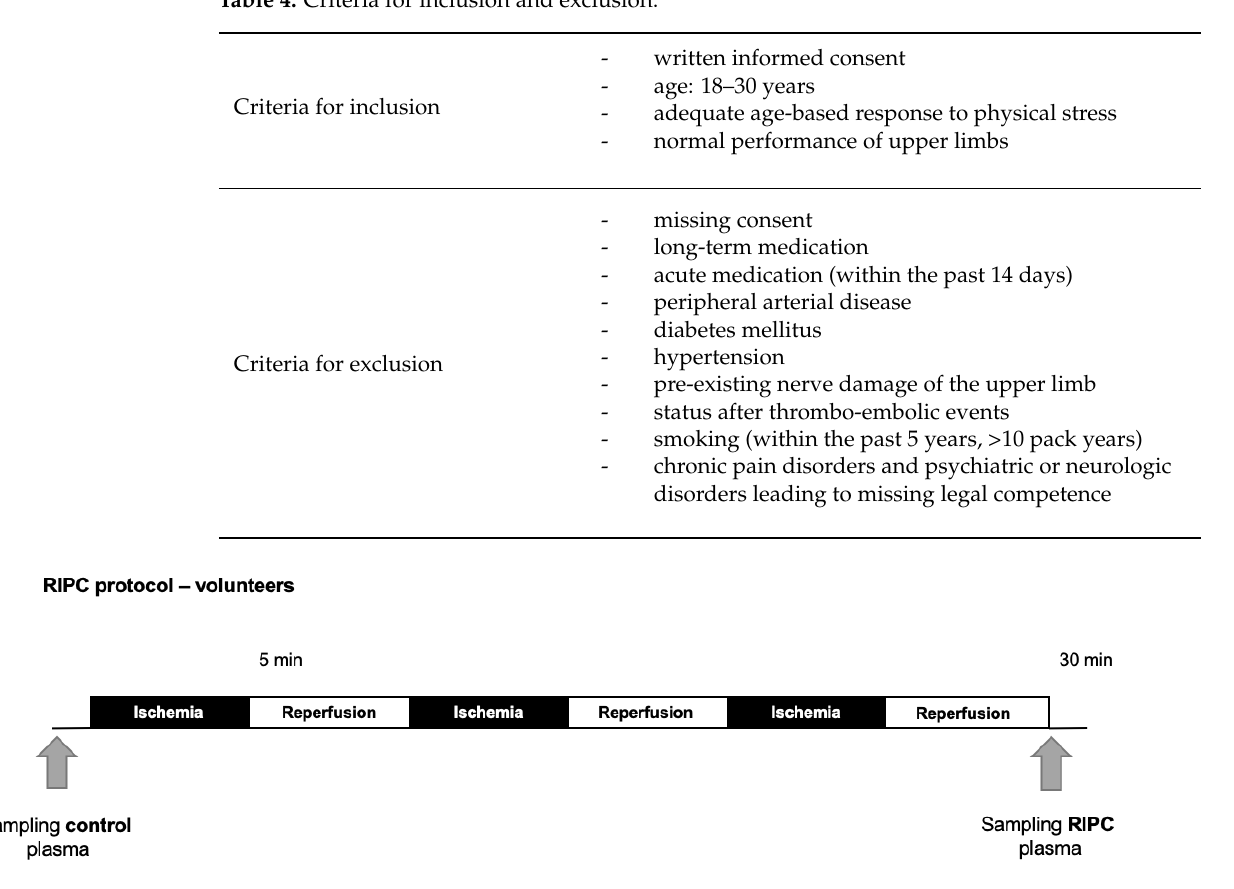
Figure 2. Schematic diagram of the experimental protocol (Part 1) for induction of control (Con) and RIPC blood plasma sampled in young, male volunteers. RIPC was induced by three cycles of ischemia (5 min) at the upper left arm, followed by 5 min of reperfusion.